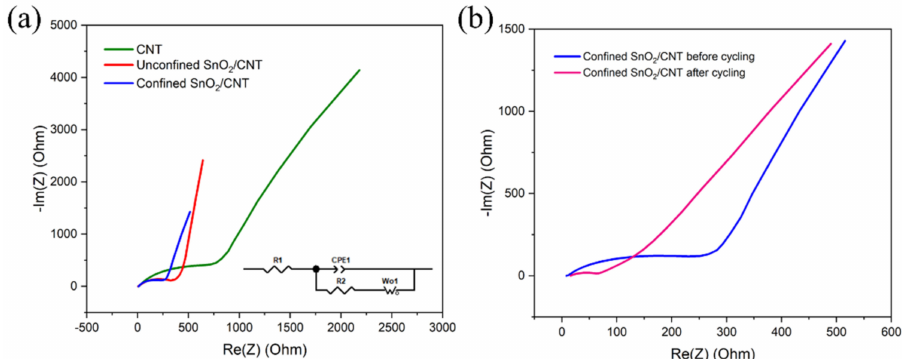
Figure 8. Electrochemical impedance ( a , b ) characterization of CNT anodes and anodes with un- confined SnO 2 and confined SnO 2 inside a CNT before and after 100 cycles (the inset shows the equivalent